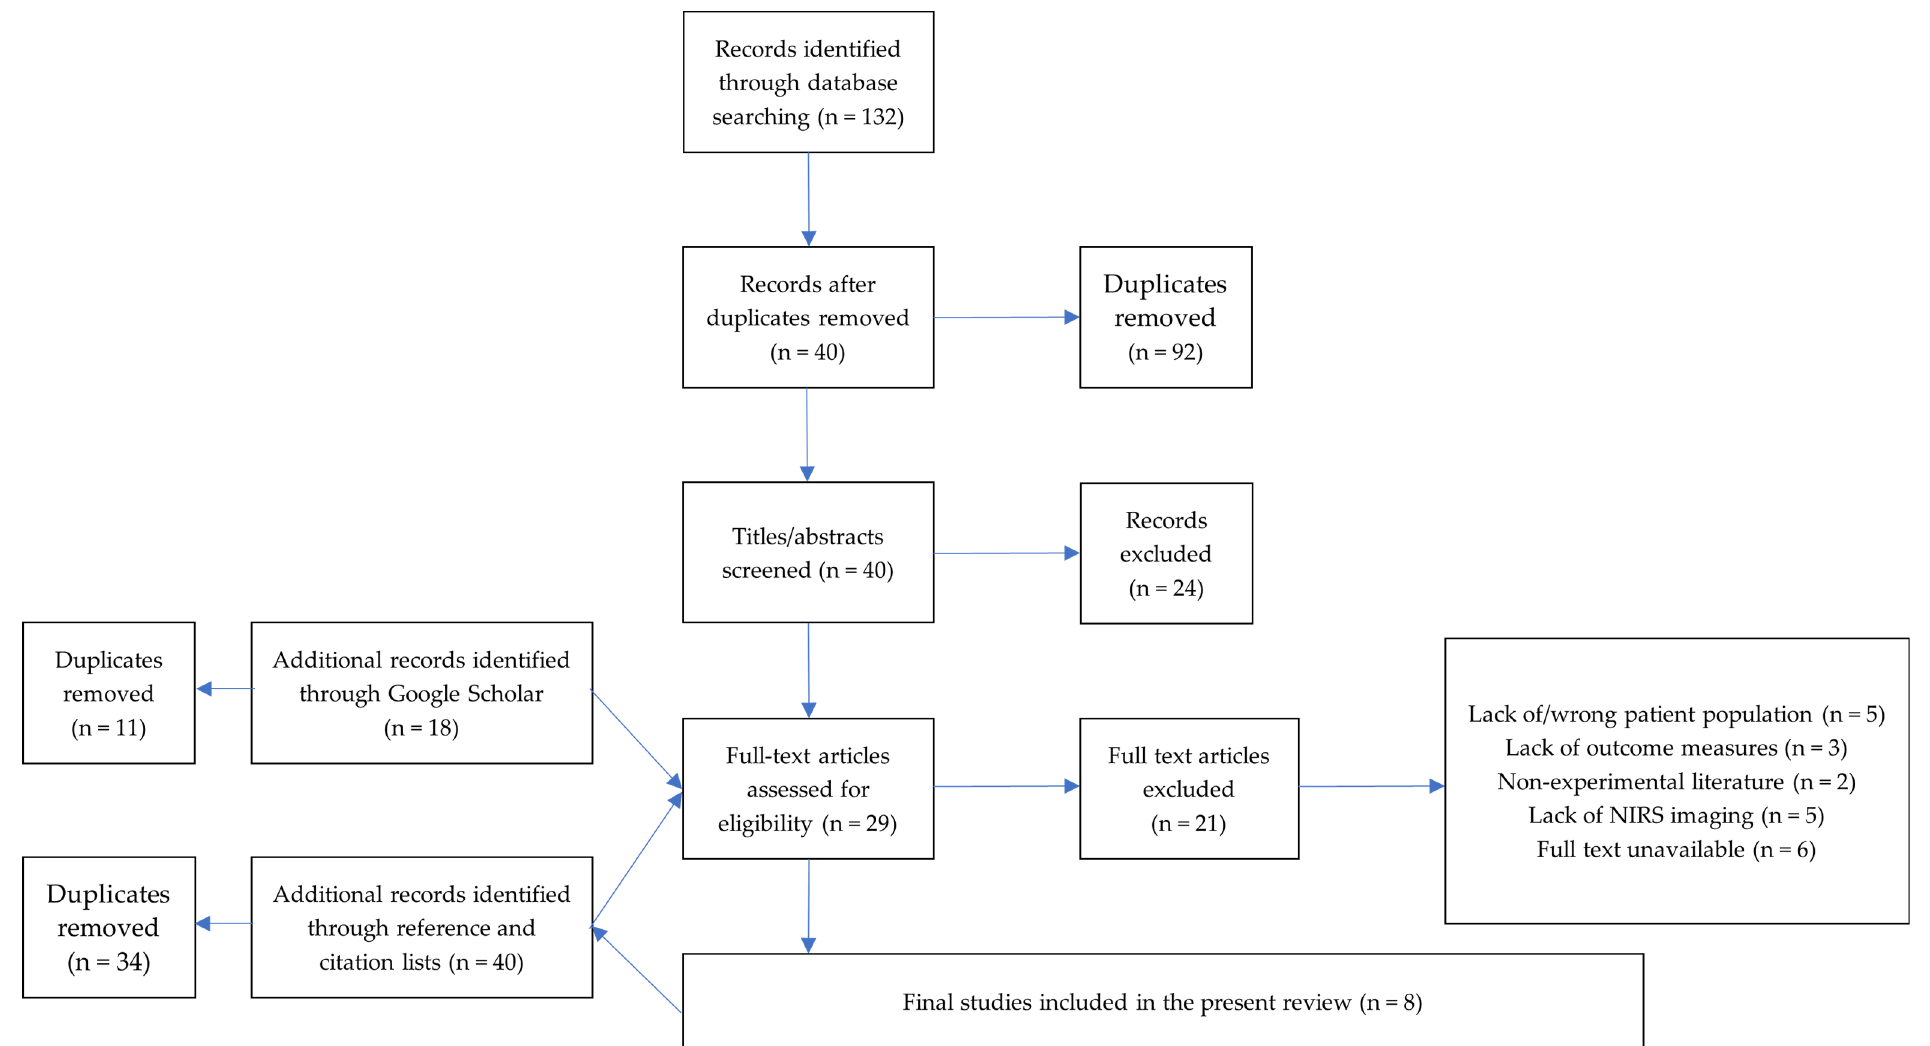
Figure 1. Flowchart to represent the search and screening process. A total of eight articles were deemed appropriate for this review.